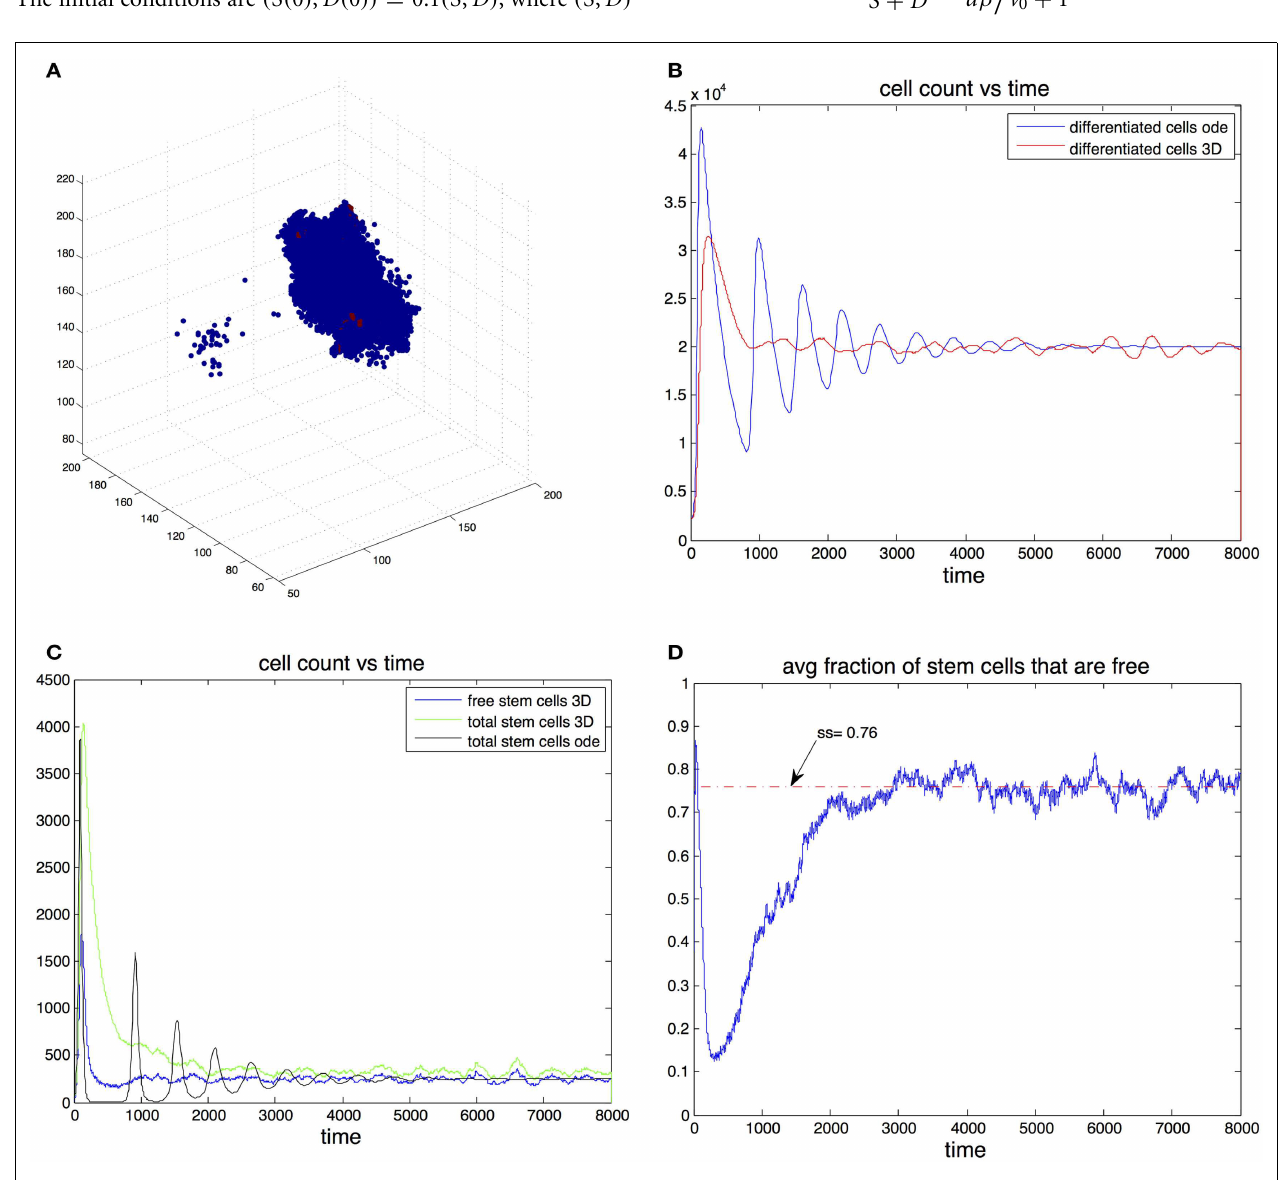
ode (black) and expected cell count in spatial-dimensional model (green). The expected number of cells is in the spatial model is shown in blue. (D) Expected fraction of stem cells that are free in the three-dimensional model. Parameters in all figures are: p 0 = 0 . 7, v 0 = 0 . 2, g = 2 × 10 5 , β = 1, and d = 0 . 0025